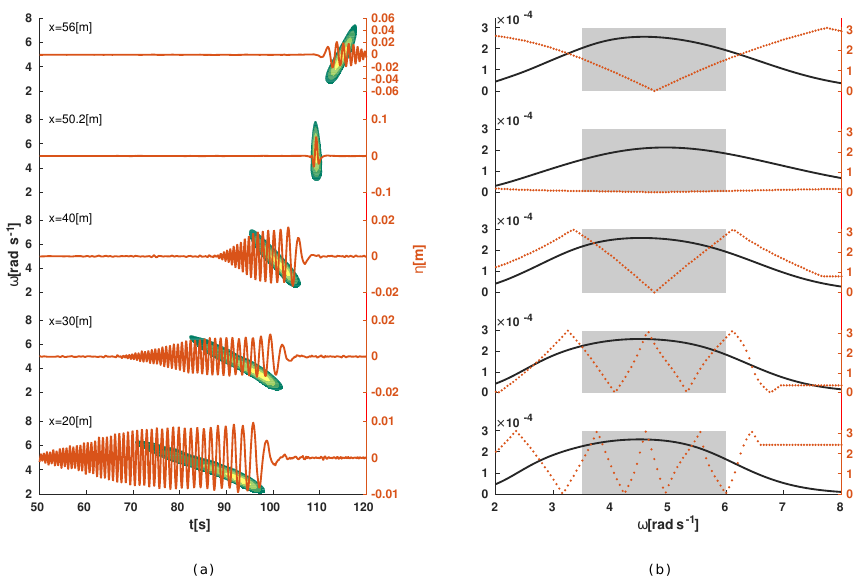
Figure 8. Case 202002. (a) Time signals at various positions of the evolution of the critical group event with the filled contour plot of wavelet spectra. The vertical axis at the left represents the wave frequency ω and the vertical axis at the right represents the surface elevation in meters. (b) The corresponding time-averaged wavelet spectra (solid line) and the time spreading (dotted line). Observe that at x = 50.2m the time spreading vanishes identically in the shaded area. The shaded areas show the chosen frequency interval of the most energy carrying modes.